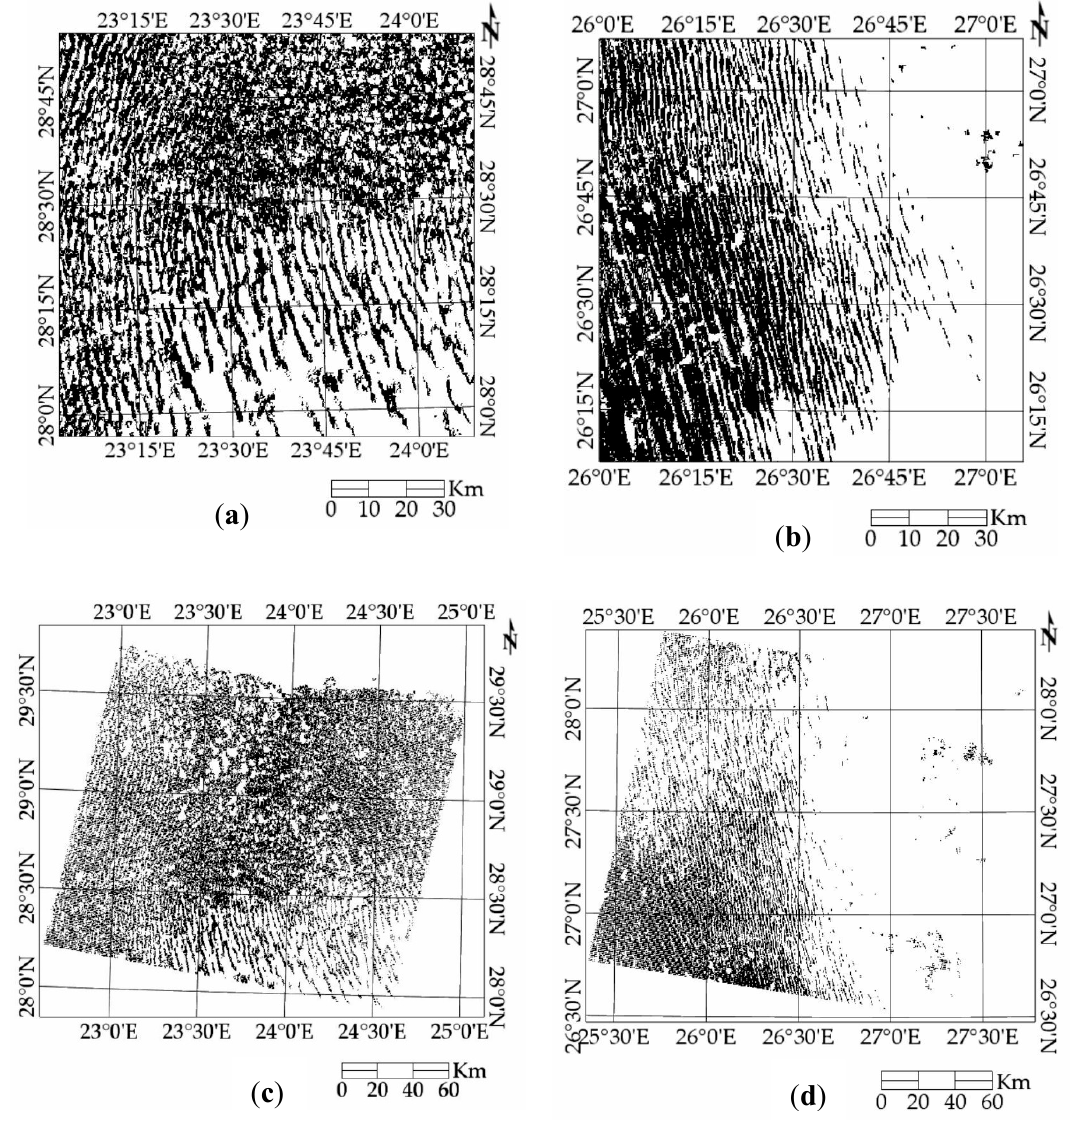
Figure 20. Cluster 13 binary masks ( a ) Sentinel 2A MSI Libya 4 ( b ) Sentinel 2A MSI Egypt 1 ( c ) Landsat 7 Libya 4 ( d ) Landsat 7 Egypt 1. Black color pixel represents the Cluster 13 pixels.